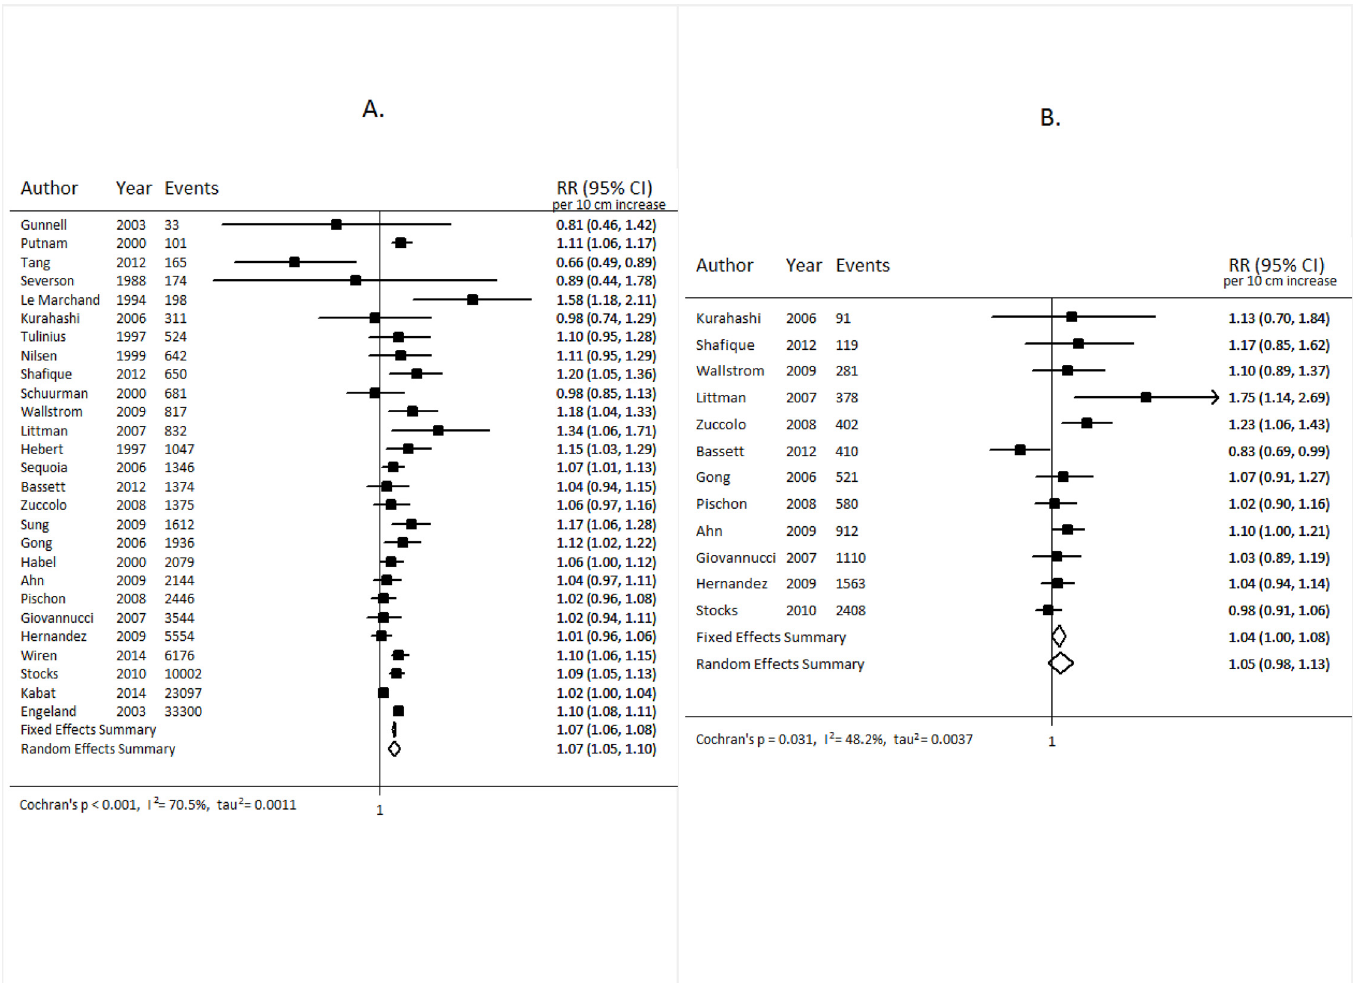
Fig 3. Forest plot for prospective studies of adult height and prostate cancer. Overall prostate cancer (A); aggressive prostate cancer (B). RR, relative risk.